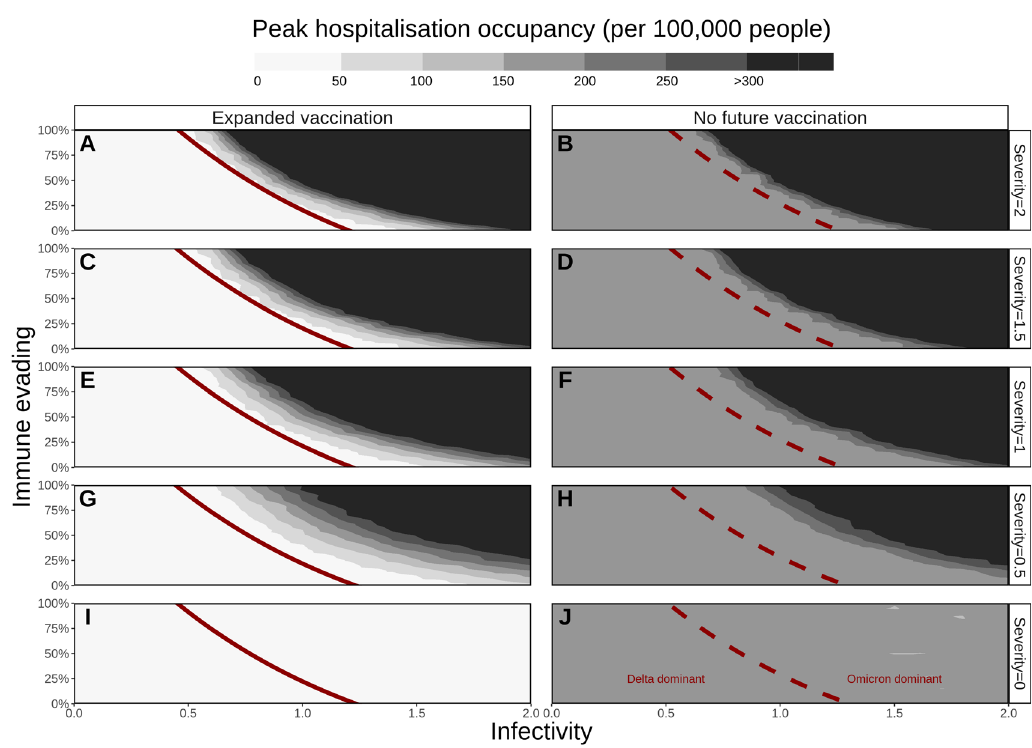
Fig. 1 Peak daily hospital occupancy for a range of variant properties (number of beds per 100,000 population over the six-month simulation period). The threshold (50% prevalence, see Supplementary Fig. 5) for Omicron ’ s dominance is presented by red lines (solid for expanded vaccination in panels A , C , E , G , and I , dashed for no future vaccination in panels B , D , F , H , and J ). Expanded vaccination includes third doses for adults (6 months after the second dose) and vaccinating 5-11-year-olds. Rows represent Omicron ’ s potential severity (0 to 2) relative to Delta (1). Horizontal axes represent the range of Omicron ’ s potential infectivity (0 to 2) relative to Delta (1), left vertical axes represent Omicron ’ s potential immune-evading capacity (0 to 100%). The peak hospital occupancy per 100,000 people has been conservatively capped at 300 per 100,000, a value that ranges for European countries between 220 (Sweden) and 800 (Germany) 16